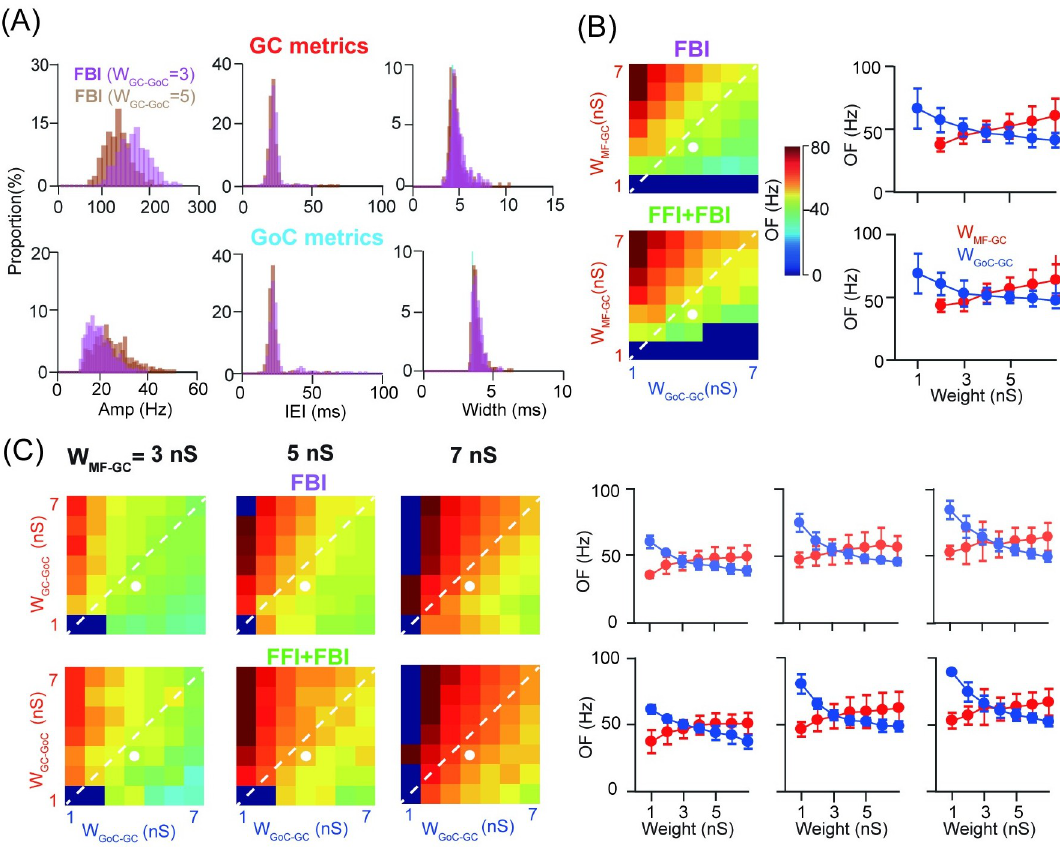
Fig 2. Oscillation frequency controlled by excitation and inhibition strength. (A) Example oscillation metrics changed by the excitation strength of GC-GoC synapses. (B) Modulation of oscillation frequency (OF) over increasing W MF − GC and W GoC − GC strengths under two network scenarios (left). The white dash line indicates the ratio of excitation and inhibition as 1. The point = 3 nS and W GoC = 4 nS fixed for showing the monotonic change on the right plot. marked as white is the default values W MF − GC − GC (Right)Example traces showing monotonic changes of the OF, with increasing excitation (blue) or inhibition (red) while fixing the other one along the default values. (C) Similar to (B), but in the parameter space of increasing W GC and W GoC strengths, with − GoC − GC three cases of W MF − GC . The point marked as white is the default values W GC − GoC = 3 nS and W GoC − GC = 4 nS fixed for showing the monotonic change on the right plot.